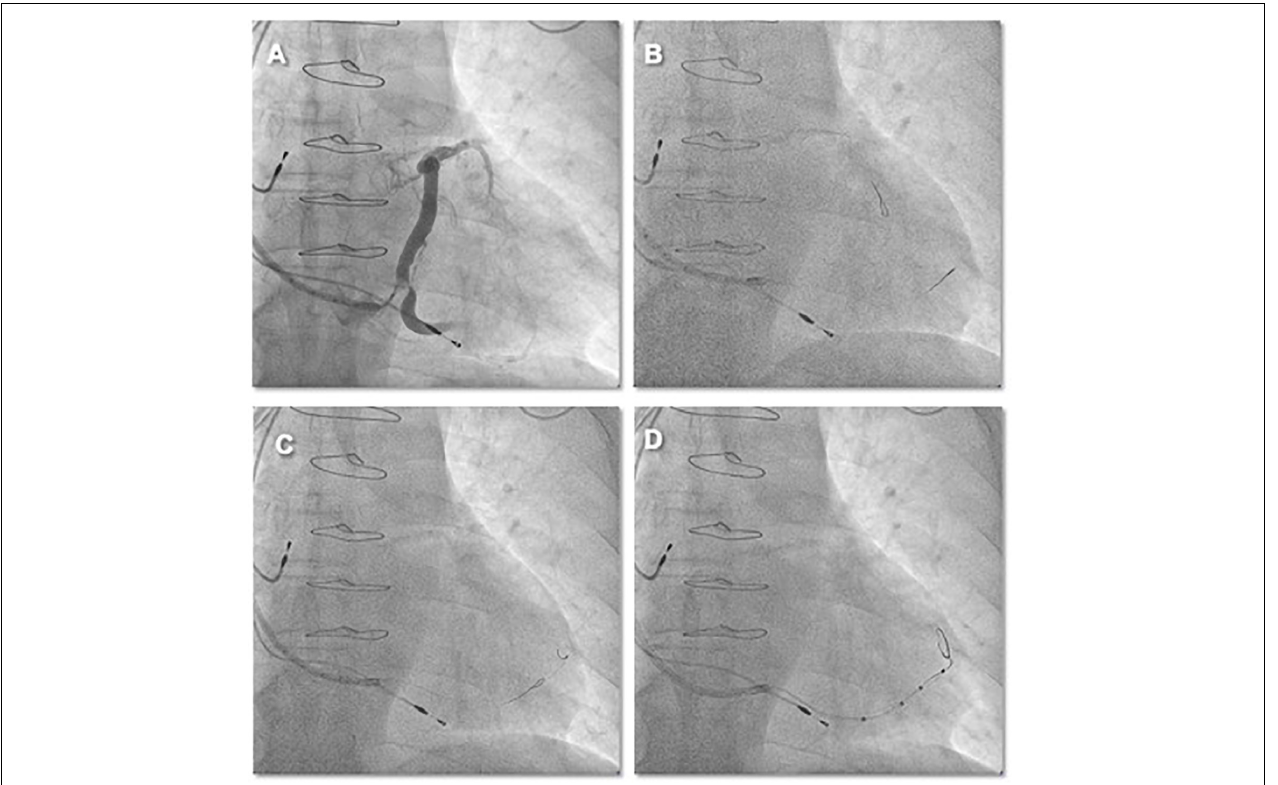
FIGURE 6 | (A) CS venography by Lee’s venogram balloon showed that the target vessel ostium was low, sharply angled, and close to the CS ostium. Without runthrough-NS floppy guidewire anchorage, the CS sheath was easy to prolapse out of the CS. (B) One runthrough-NS floppy guidewire was sent to the great cardiac vein via Lee’s venogram balloon for anchoring. (C,D) The positioning of the second guidewire through Lee’s venogram balloon against the vein’s wall effectively reduced the acuteness of the angle of the side branch and this permitted the over the wire LV lead to be further advanced over the runthrough-NS floppy guidewire to reach a stable pacing